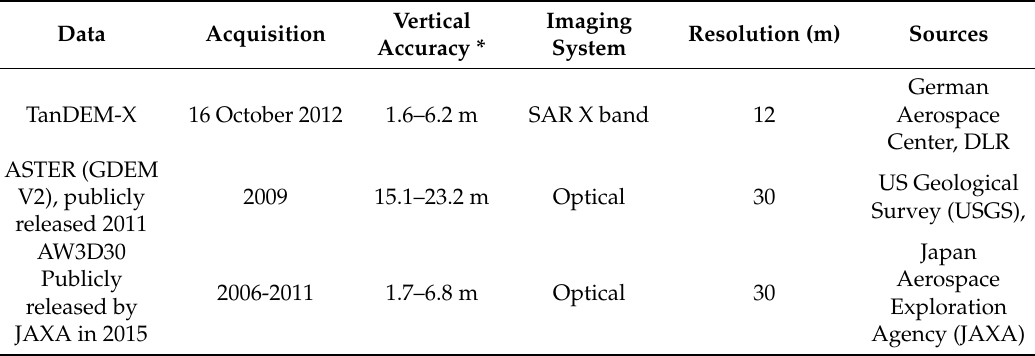
Table 1. Summary of DSMs used in this research. TanDEM-X: (TerraSAR-X Add-On for Digital Elevation Measurements), ASTER GDEM: (Advanced Spaceborne Thermal Emission and Reflection Radiometer), AW3D: (ALOS WORLD